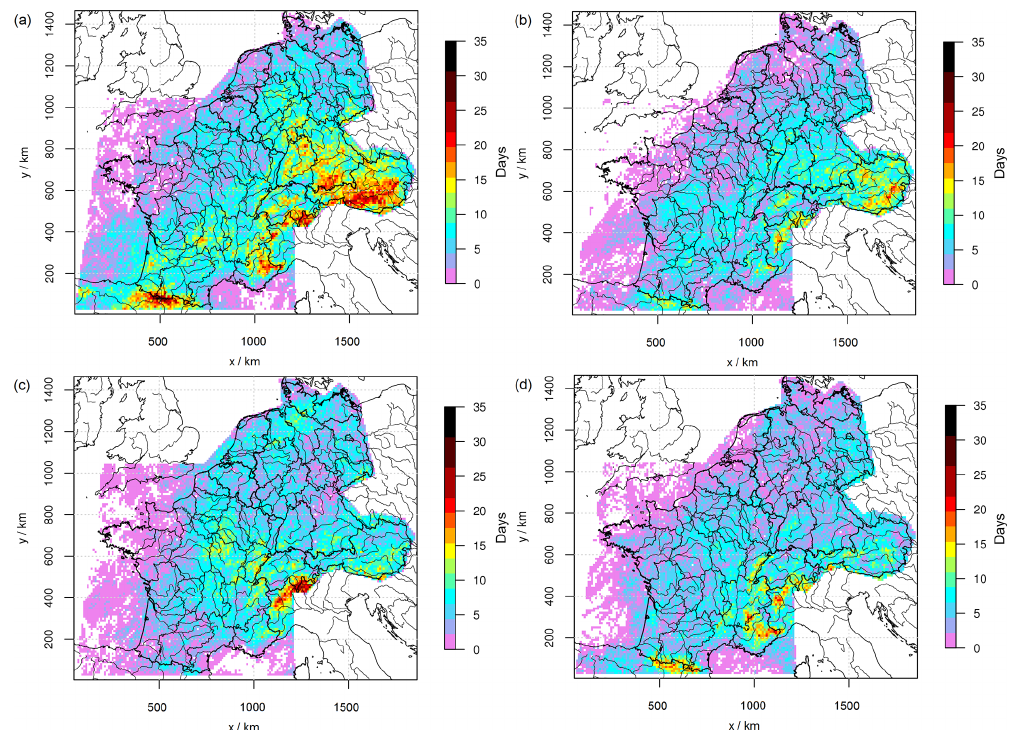
Figure 9. Annual number of thunderstorm days during the summer half-years 2006 (a) , 2010 (b) , 2001 (c) , and 2013 (d) .